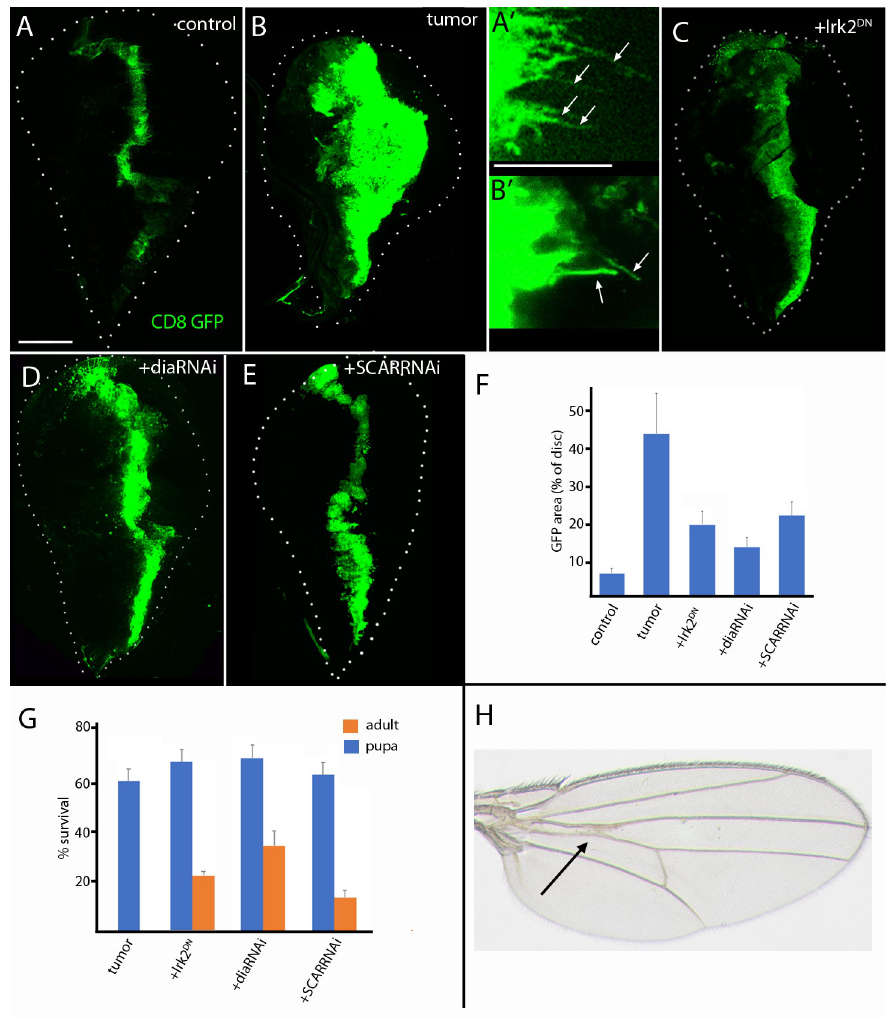
Fig 6. RET-MEN2 tumor growth and survival depends on cytonemes. (A-B’) Unfixed wing discs expressing CD8: GFP (green) driven by ptc-Gal4 . Scale bar: 100 μ m. (A) Control. (A’) Cytonemes in wild type cells (green, arrows). Scale bar: 50 μ m. (B) RET tumor, genotype: ptc-Gal4 , CD8 : GFP;UAS-RET MEN2 /UAS-CD8 : GFP . (B’) Cytonemes in RET tumor cells (green, arrows). (C-E) Unfixed wing discs expressing CD8:GFP (green) and either RET + diaRNAi (C); RET + SCARRNAi (D); and RET + Irk2 DN (E). (C) Genotype: ptc-Gal4 , CD8 : GFP;UAS-RET MEN2 /UAS-dia RNAi . (D) Genotype: ptc-Gal4 , CD8 : GFP;UAS-RET MEN2 /UAS-SCAR . (E) Genotype: ptc-Gal4 , CD8 : GFP/Irk2 DN ; RNAi UAS-RET MEN2 . (F) Quantification of the area of the disc expressing GFP (% of disc) in control, RET tumor, or RET and either diaRNAi, SCARRNAi or Irk2 DN . Significance was analyzed using Student’s t -test ( P < 1.10 − 5 ) with 15–18 discs. (G) Survival of RET-tumor and RET and either diaRNAi, SCARRNAi or Irk2 DN to pupa (blue) and adult (orange). Significance using Student’s t -test for adults is ( P < 0.001), n = 30–40 for each genotype. (H) RET tumor, diaRNAi wing blade; genotype: ptc-Gal4 , CD8 : GFP;UAS-RET MEN2 /UAS-dia RNAi . Arrow points to abnormal crossvein. colorectal, lung and thyroid and stem-cells derived cancers [42–44]. Our work provides proof principle for tumor suppression by interfering with cytoneme-mediated signaling.